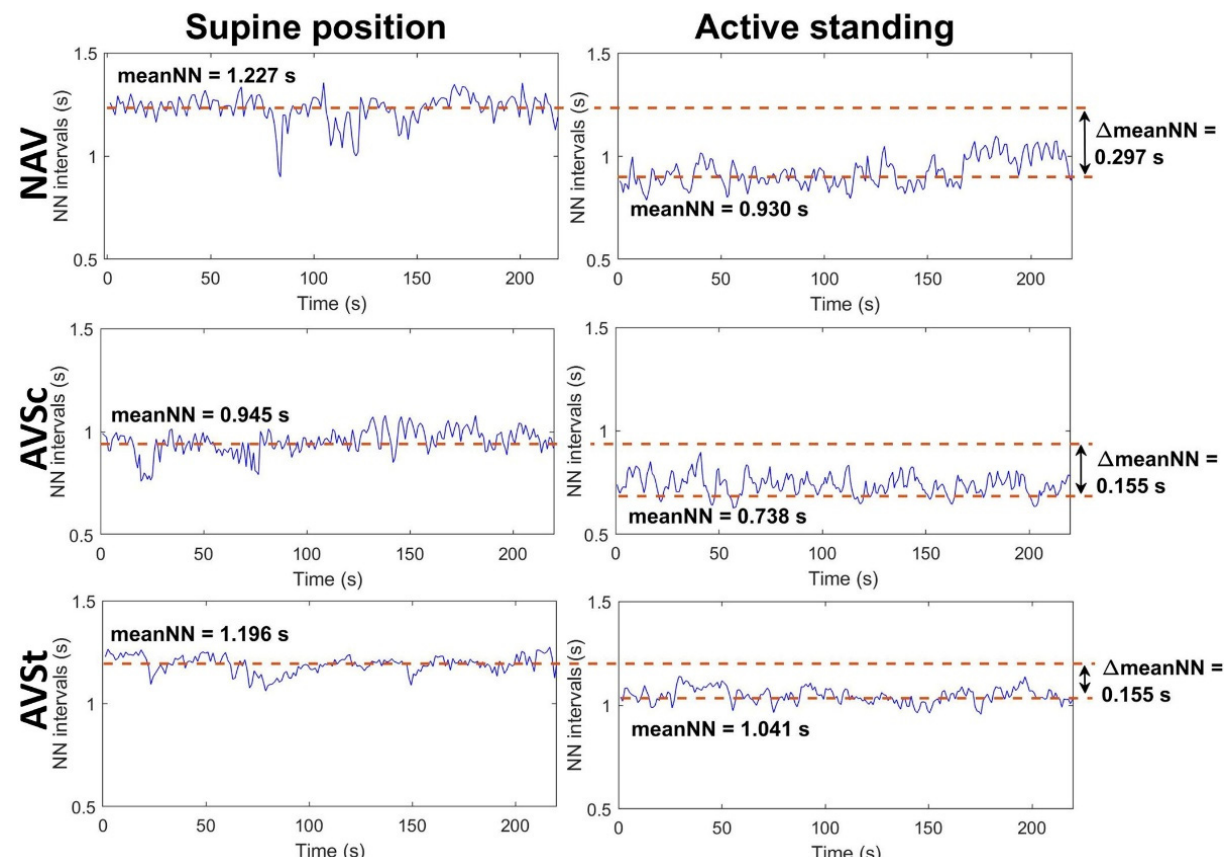
Figure 1. Example of HRV time series from one NAV subject (upper panels), one AVSc patient (middle panels) and one AVSt patient (lower panels) while they were in supine position (left panels) and active standing (right panel). The NAV subject is a 46-year-old man with a BMI of 25.565 kg/m 2 , a Vmax of 1.2 m/s, an AVA of 3.9 cm 2 , an AVAi of 2.02 cm 2 /m 2 , a PGmean of 2 mmHg, a PGmax of 5 mmHg and an LVEF of 60%. The AVSc patient corresponds to a 30-year-old-man with a BMI of 26.3 kg/m 2 , a Vmax of 1.05 m/s, an AVA of 4.2 cm 2 , an AVAi of 2.2 cm 2 /m 2 , a PGmean of 2 mmHg, a PGmax of 4 mmHg and an LVEF of 68%. The AVSt patient is a 53-year-old man with a BMI of 30.191 kg/m 2 , a Vmax of 5.6 m/s, an AVA of 0.5 cm 2 , an AVAi of 0.25 cm 2 /m 2 , a PGmean of 57 mmHg, a PGmax of 97 mmHg and an LVEF of 55%. MeanNN: mean value of all NN intervals in the time series, NAV: normal aortic valve, AVSc: aortic valve sclerosis, AVSt: aortic valve stenosis. ∆ meanNN: the difference between meanNN values at the supine position minus values at active